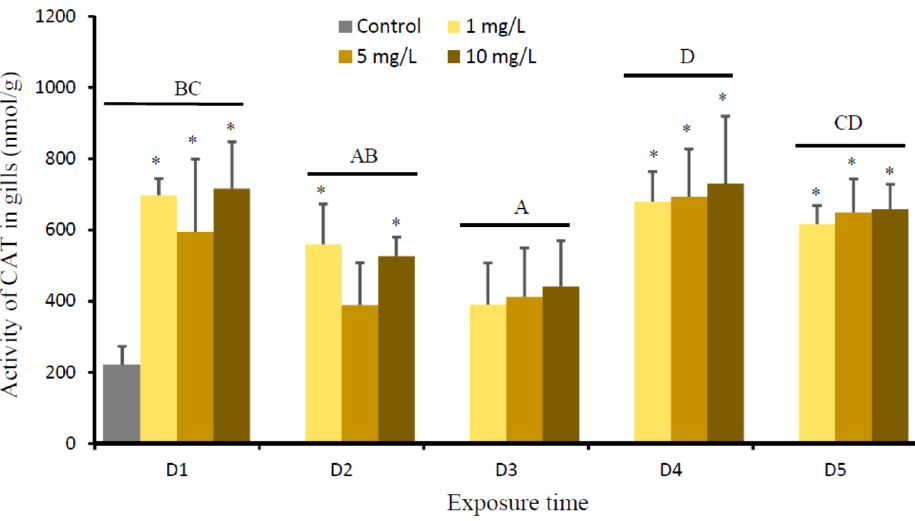
Figure 4. Activity of catalase (CAT) (nmol/g) in gills of O. niloticus of the control group and after exposed to 1, 5, and 10 mg Cu/L. Different capital letter indicates significance difference of time effect on CAT according to Tukey multiple comparison test ( P < 0.05). Asterisk indicates significance difference of Cu effect on CAT for each time group as compared to the control ( P < 0.05) according to Tukey multiple comparison test.